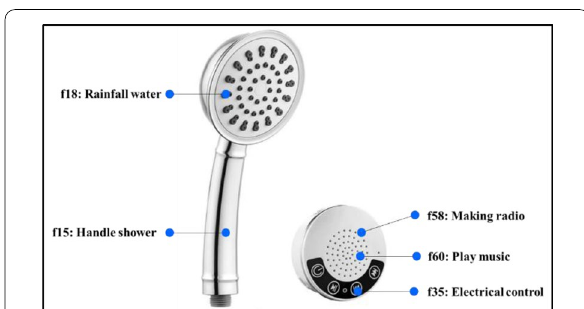
Figure 7 Product with function f35, f60, f18, f58, and